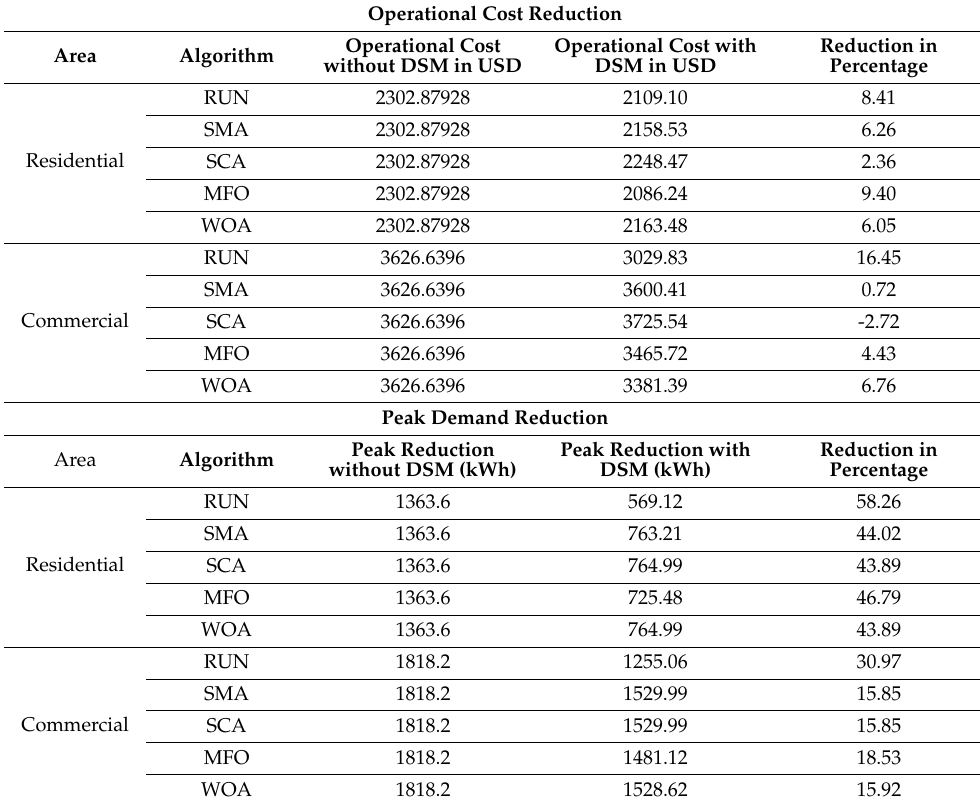
Figure 12. Load shifting results for commercial consumers. Table 5. Operational cost and peak demand reduction due to load shifting.